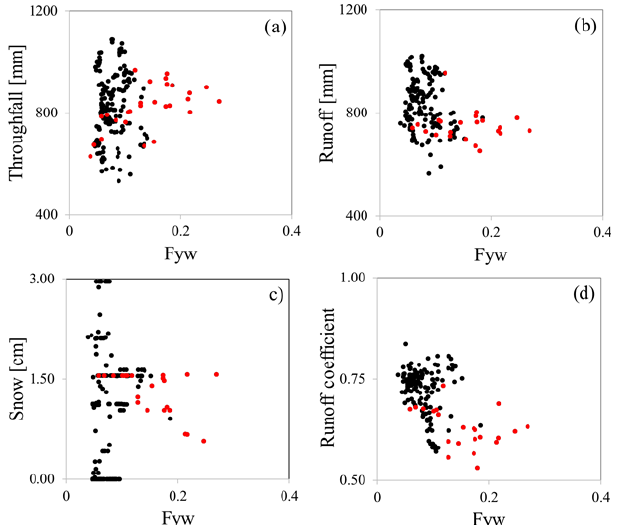
Figure 8. Testing hypothesis 3 (Fyw centered around a specific month does not differ by more than ± 0 . 04 within this month): box- plot of all Fyw results of a specific month. Whiskers are the upper and lower 1.5 interquartile range, and circles are outlier values. The number of data points for each month is given in the brackets on the horizontal